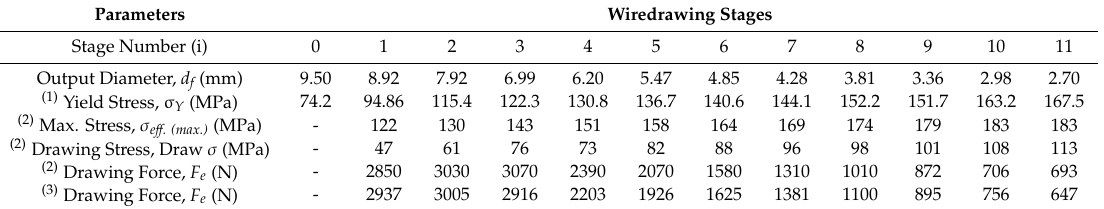
Table 5. Stresses and drawing force obtained by Deform 2D simulations (±5% error tolerance). Parameters